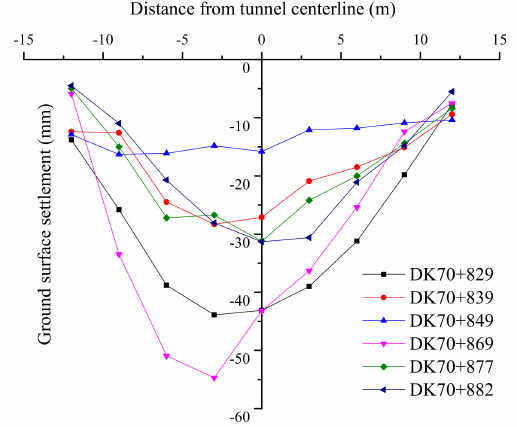
Figure 13. Surface settlements monitoring results of section DK70 + 869: ( a ) Development of GSSs; ( b ) Surface settlement troughs of typical excavation stages.